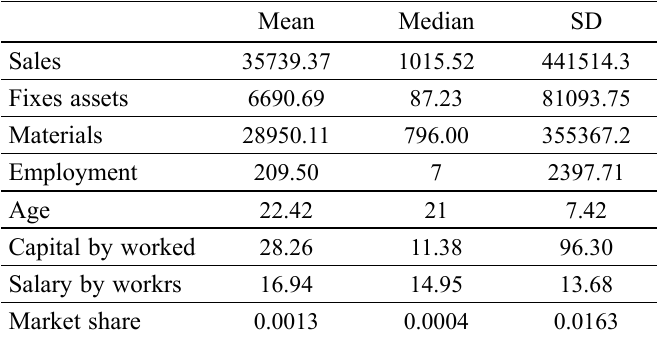
Table 1. Summary